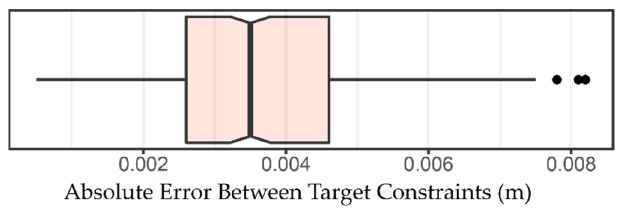
Figure 4. Box plot of absolute error distance between all 125 valid registration target constraints.